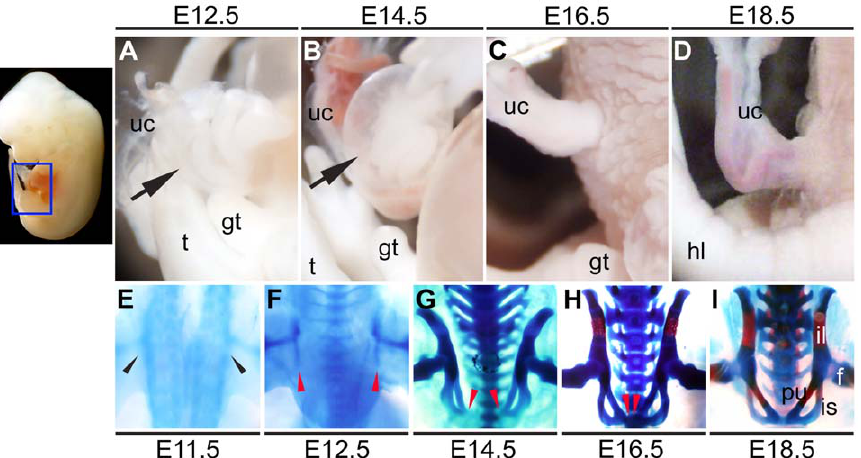
Figure 1. The development of the ventral body wall and the pelvic girdle. Wild-type embryos exhibited a physiological umbilical hernia in the ventral body wall at E12.5 and E14.5 ( A, B ). Black arrows indicate the physiological umbilical hernia. The physiological umbilical hernias were recovered in wild-type late staged embryos at E16.5 and E18.5 ( C, D ). The anlagen of the pelvic girdle start to be observed at around E11.5 ( E ; black arrowheads). The jointing of the hip bones (pubic symphysis) was not formed yet in wild-type embryos at E12.5 and E14.5 ( F, G ). The embryonic pelvic girdle develops to the midline at E16.5 and the pelvic ring is formed at E18.5 ( H, I ). Red arrowheads indicate the midline edges of the pelvic girdle primordia (future symphysial surfaces of the pubis). f: femur, gt: genital tubercle, hl: hind limb, il: iliac bone, is: ischial bone, pu: pubic bone, t: tail, uc: umbilical cord.